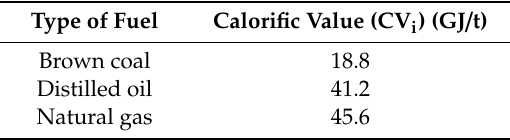
Table 2. Energy-based equivalence of certain fuels.